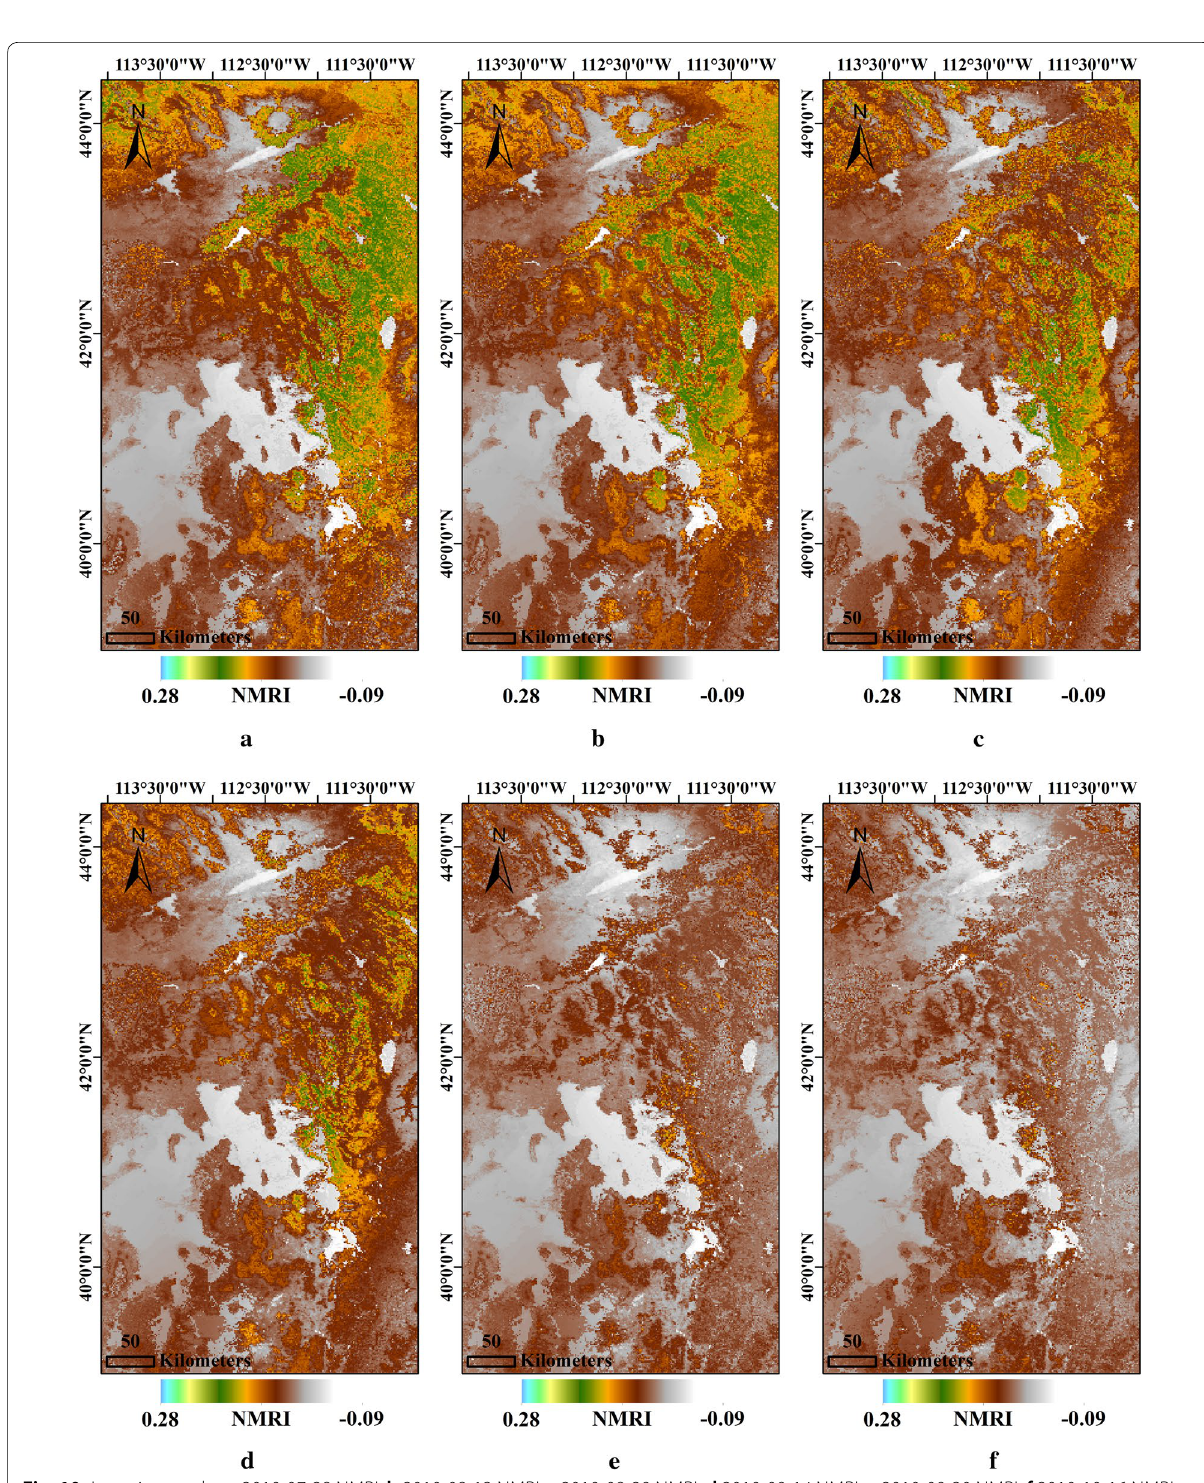
Fig. 10 Inversion results: a 2010-07-28 NMRI; b 2010-08-13 NMRI; c 2010-08-29 NMRI; d 2010-09-14 NMRI; e 2010-09-30 NMRI; f 2010-10-16